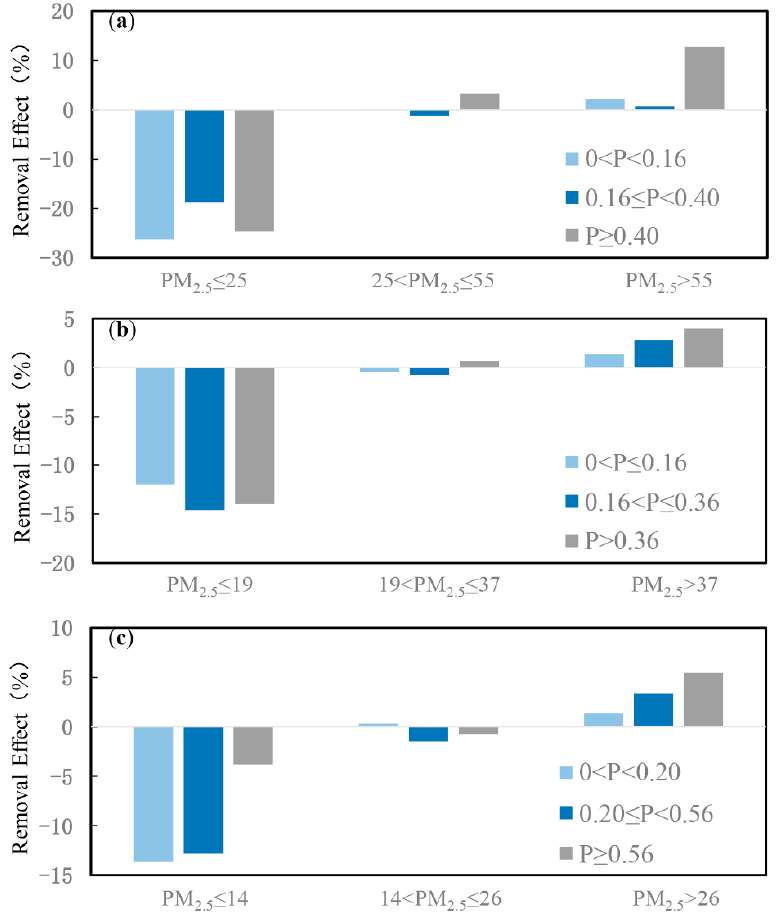
Figure 5. Differences in removal effect of precipitation under different precipitation intensity (unit Figure 5. Di ff erences in removal e ff ect of precipitation under di ff erent precipitation intensity mm/hour) and PM 2.5 mass concentration (before precipitation) (unit µg/m 3 ) conditions over ( a ), BTH, (unit mm / hour) and PM 2.5 mass concentration (before precipitation) (unit µ g / m 3 ) conditions over ( a ), ( b ) YRD, and ( c ) PRD regions. BTH, ( b ) YRD, and ( c ) PRD